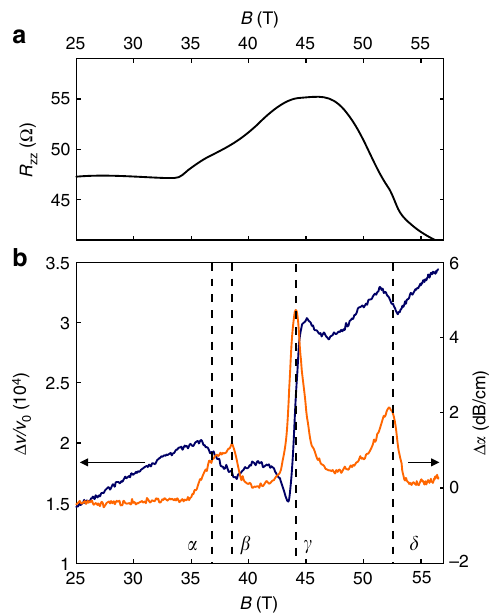
Fig. 1 High fi eld transport and elastic properties of HOPG at T = 4.2 K. a c -axis magnetoresistance ( R fi eld, B , oriented zz ) as a function of magnetic parallel to the c -axis in HOPG graphite. b elastic properties of HOPG for B || c at 4.2 K: the sound velocity ( Δ v y -axis) and attenuation ( Δ α v 0 in orange left ( ω ) in blue right y -axis) change for the longitudinal acoustic mode c 33 propagating along the c -axis, at a frequency f = 255 MHz. The dashed lines indicate the transition fi eld for the different transitions labeled α , β , γ , and